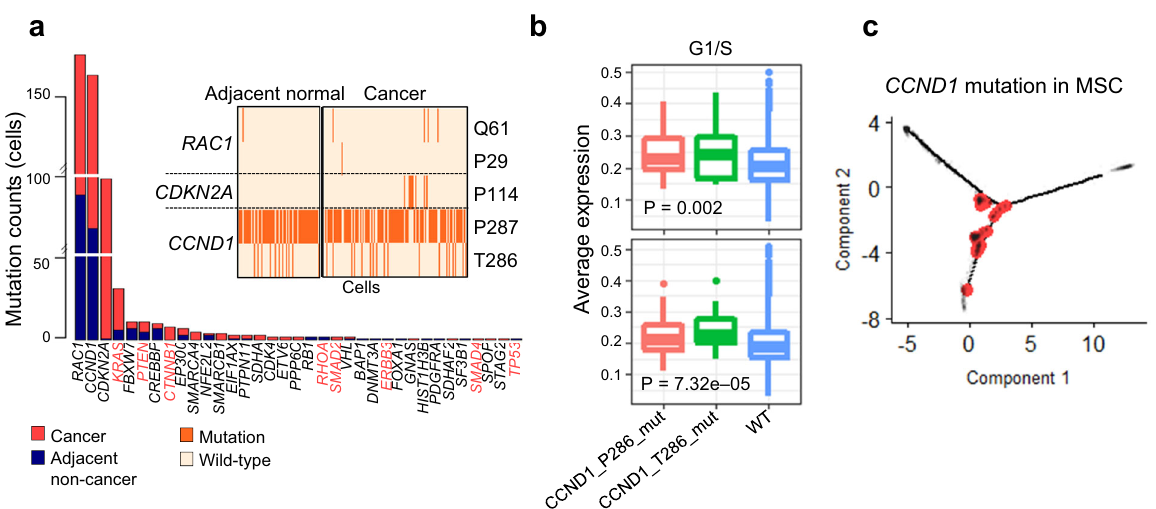
Fig. 4 Association between CCND1 mutation and the intestinal tumor cell lineage. a Mutation counts for 35 pan-cancer hotspot genes. Genes denoted in red along the x axis harbor mutations according to a TCGA gastric cancer study 5 . Inset plot represents the cells with mutations in RAC1 , CDKN2A , and CCND1 in the adjacent non-cancer tissue and cancer samples. b G1/S gene scores for cells with CCND1 hotspot mutations in premalignant cells (upper) and tumor cells (bottom). P values were calculated by ANOVA. c Cells with mutations in CCND1 , especially MSCs, mapped on a trajectory tree of IM and tumor cells. Red dots indicate mutated